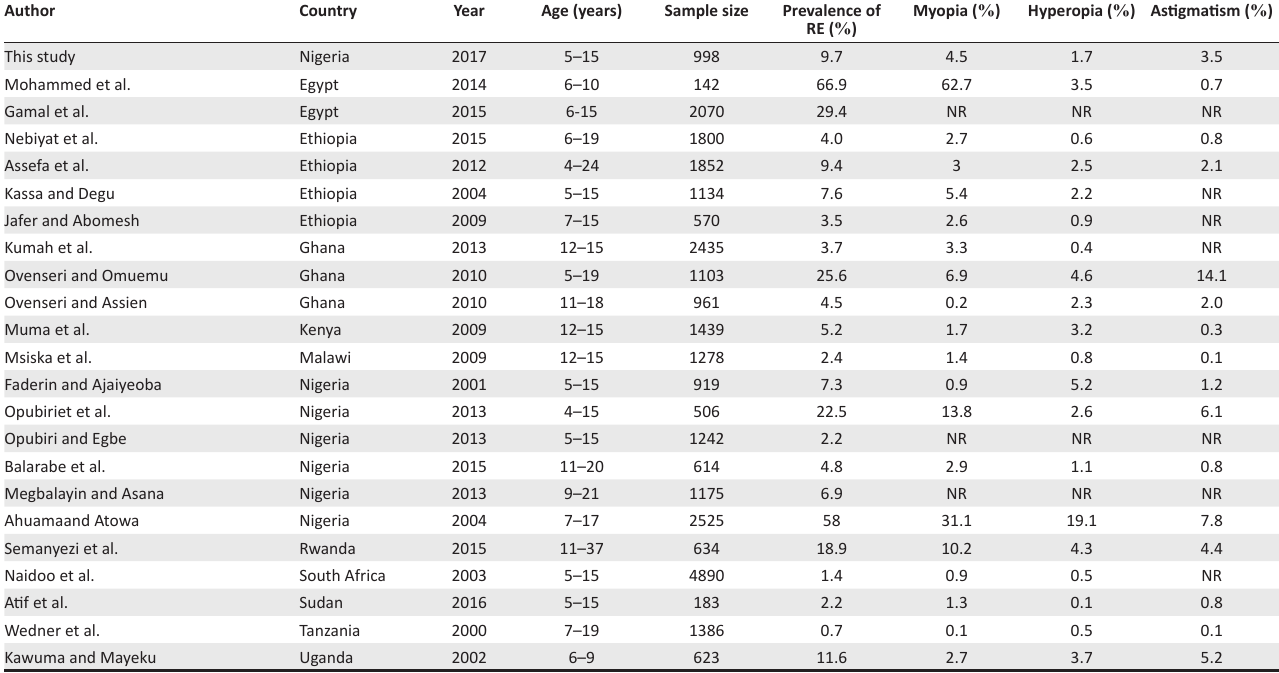
TABLE 5: Prevalence of refractive error studies in children in Africa.